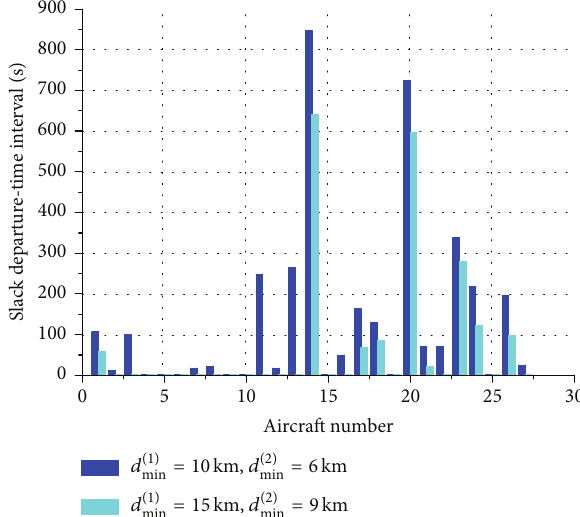
Figure 18: Slack departure-time intervals with two different minimum requirements of separations.